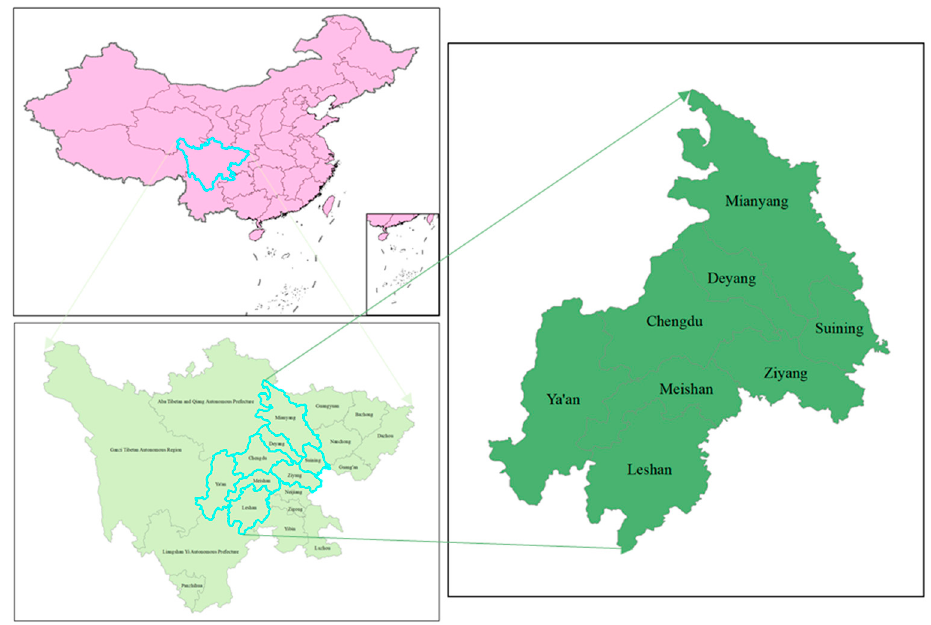
Figure 1. Location map of the study area.